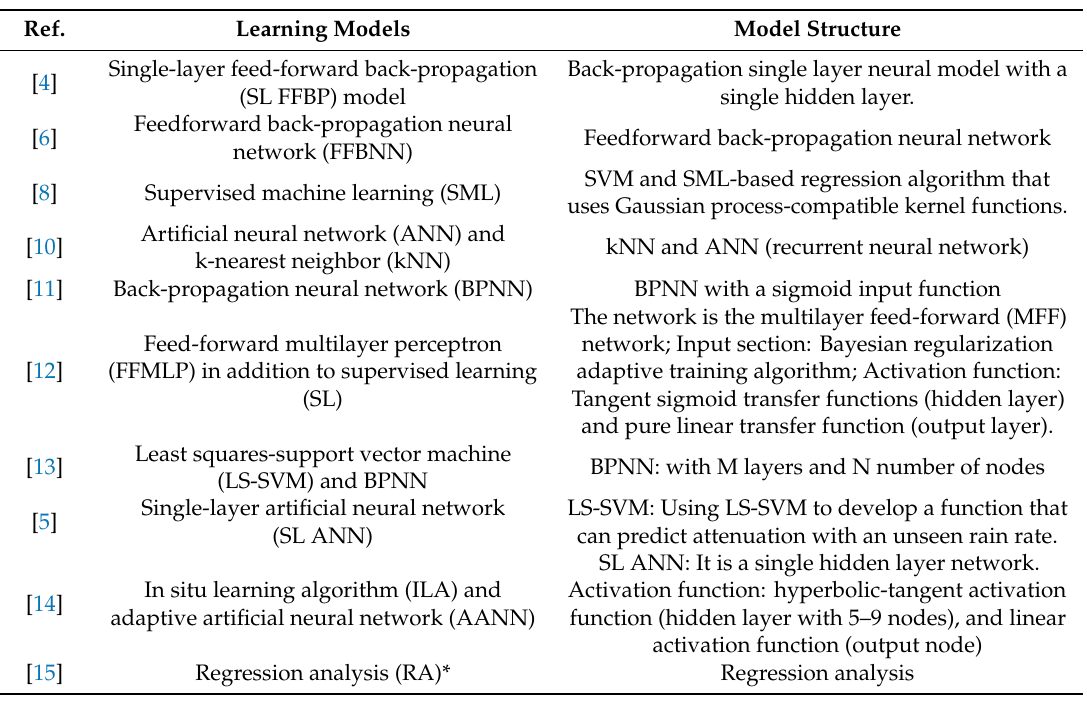
Table 1. Learning algorithms used in currently published LARA model’s rain attenuation model.